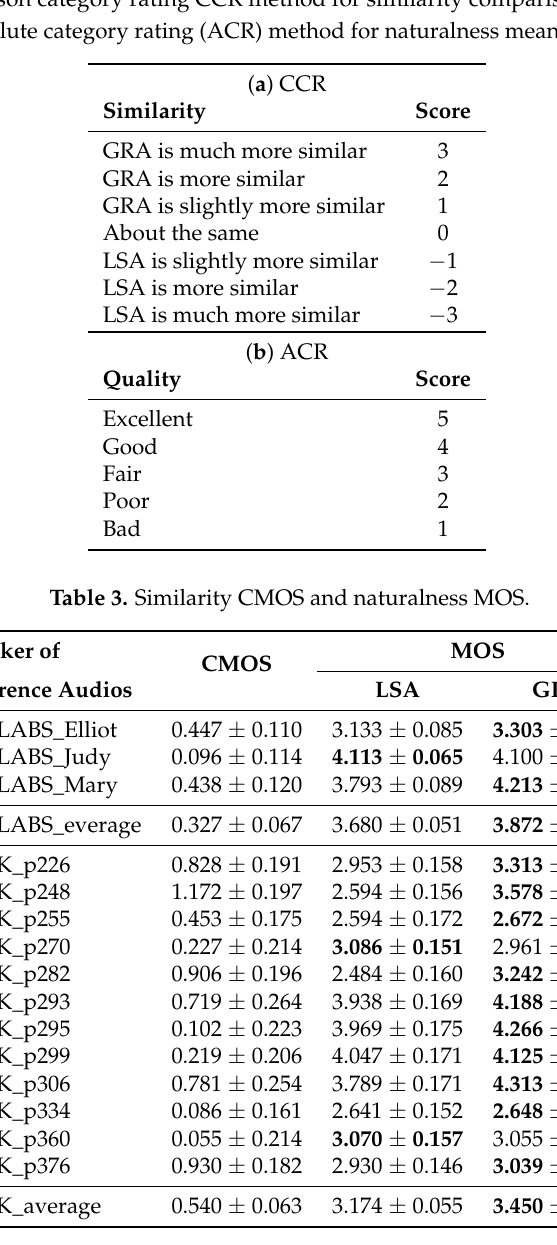
Table 2. ( a ) Comparison category rating CCR method for similarity comparison mean opinion score